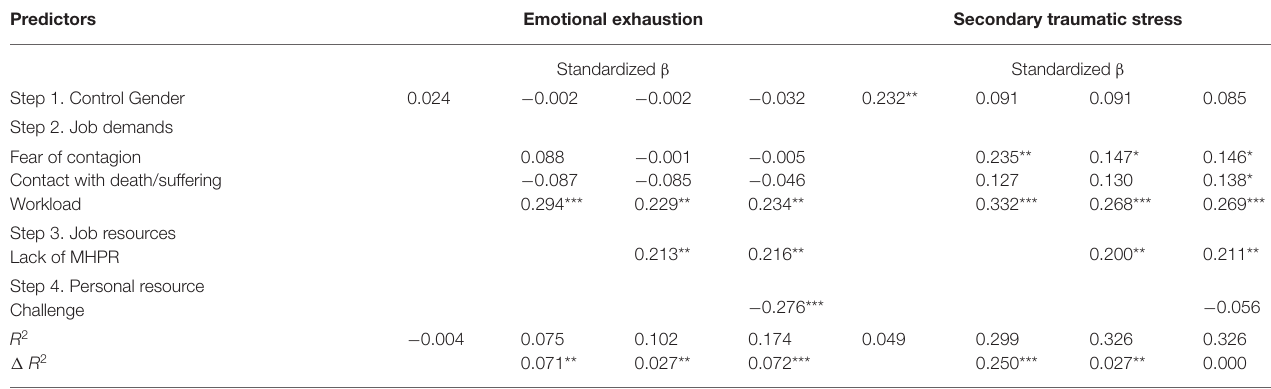
TABLE 7 | Hierarchical regression model on criterion variables of secondary traumatic stress and emotional